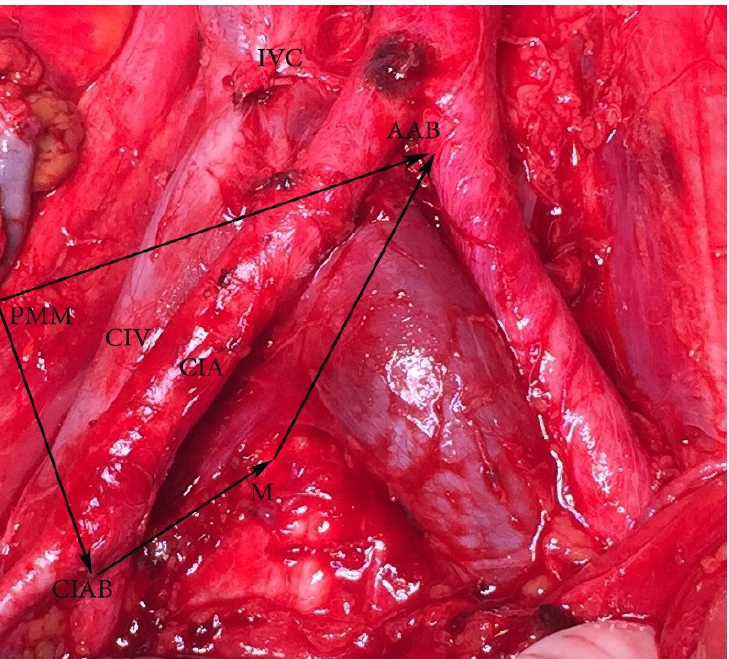
Figure 4. Common iliac lymph nodes dissection—anatomic boundaries (open surgery, right side). Dorsal—abdominal aorta bifurcation, ventral—common iliac artery bifurcation, medial—medial aspect of common iliac vessels (on the left side is mesoureter), lateral—psoas major muscle. AAB— abdominal aorta bifurcation, PMM—psoas major muscle, CIAB—common iliac artery bifurcation, M—medial aspect of common iliac vessels on the right side (on the left side is mesoureter), IVC— inferior vena cava, CIA—common iliac artery, CIV—common iliac vein.